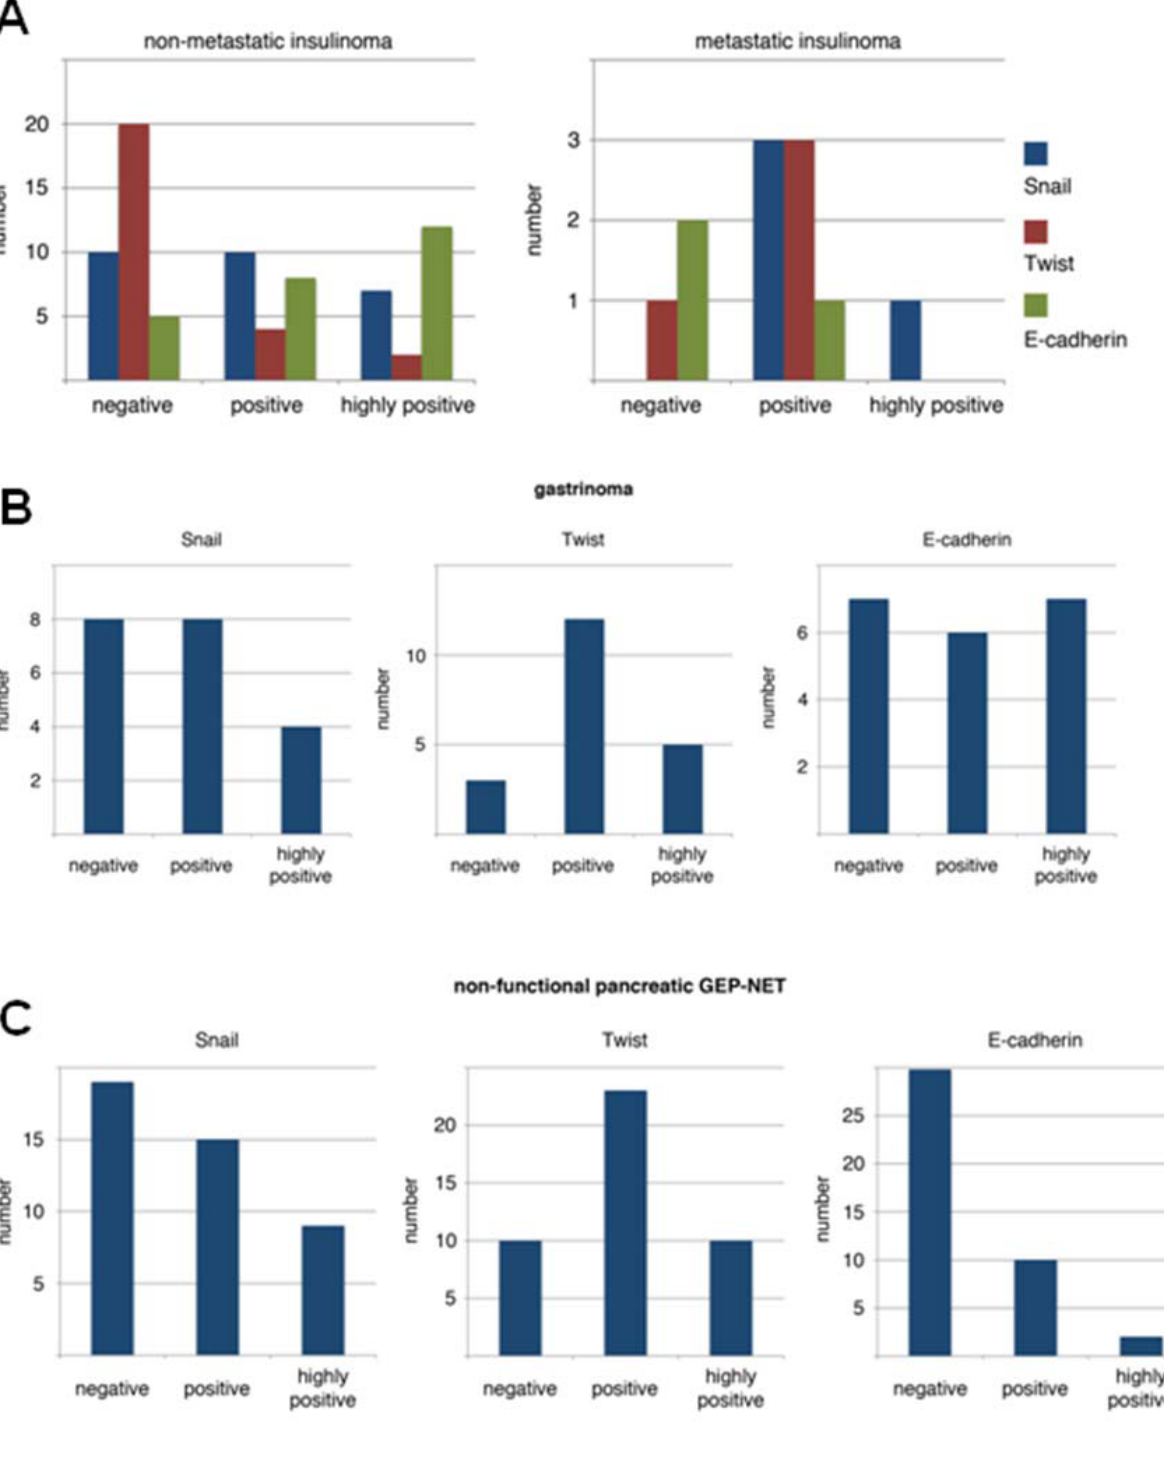
Figure 1. Results of immunohistochemistry for E-cadherin, Snail and Twist in (A) insulinomas, (B) gastrinomas, and in (C) non-functional